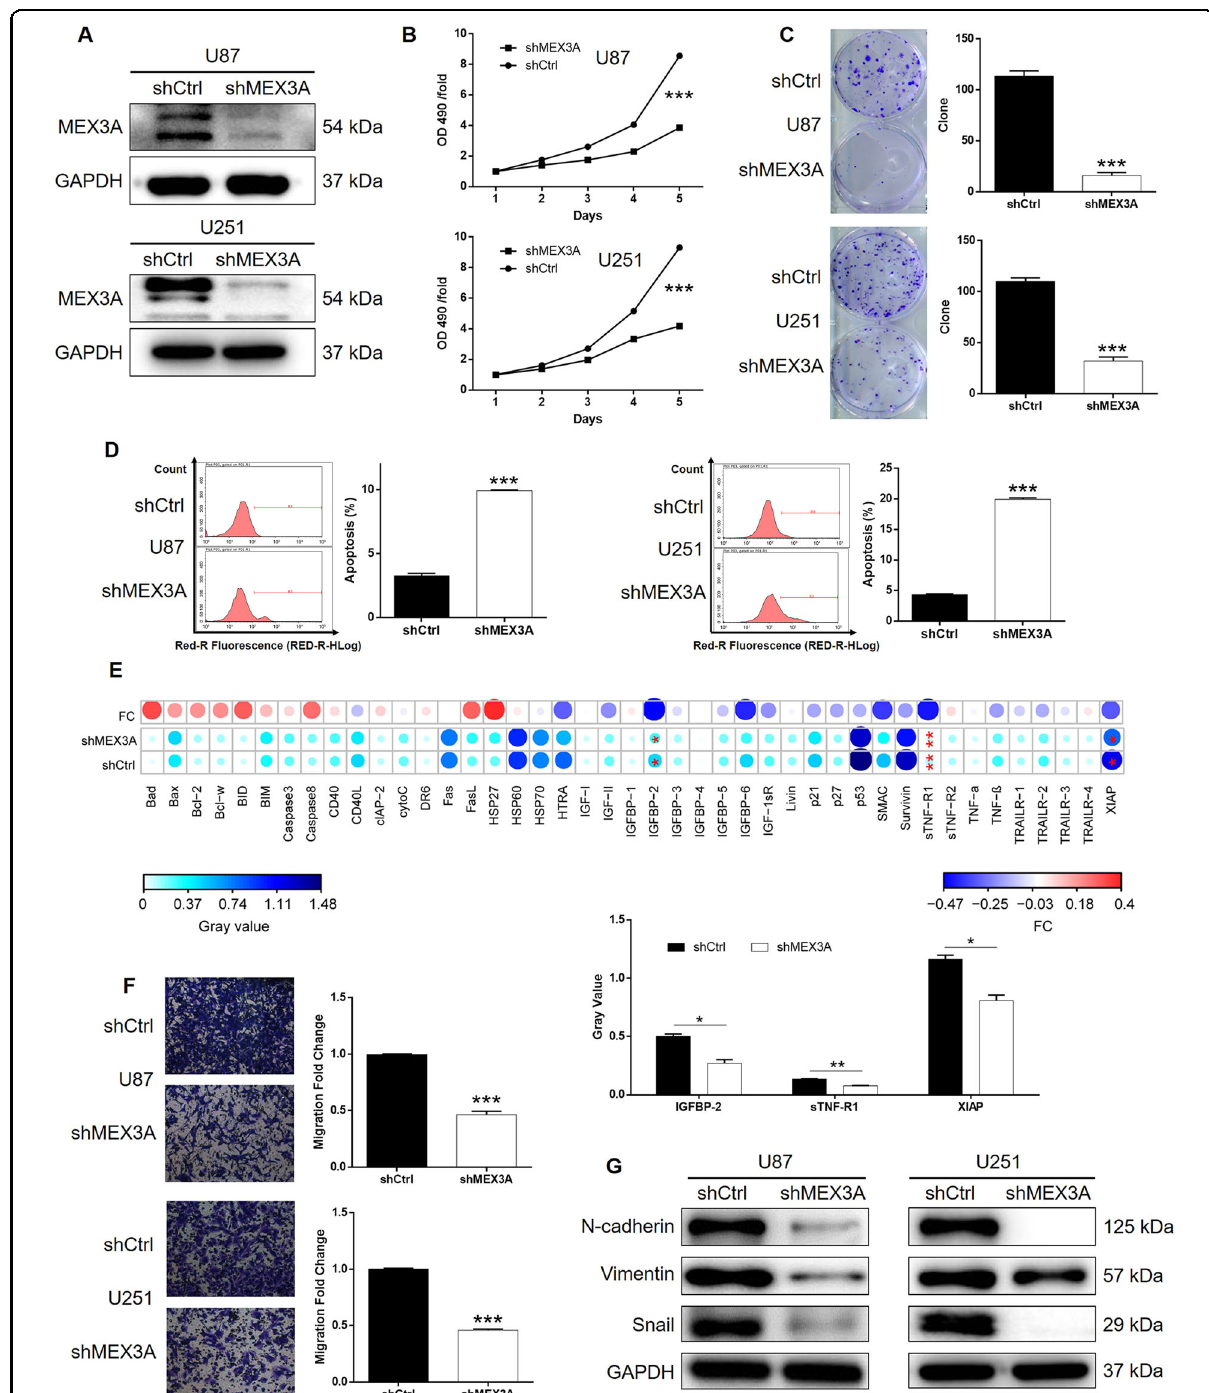
Fig. 2 MEX3A knockdown inhibited glioma development in vitro. A , B Cell models with or without MEX3A knockdown were constructed by transfecting shMEX3A or shCtrl. The knockdown ef fi ciency of MEX3A in BGC-823 and U251 cells was assessed by western blotting ( A ). B MTT assay was employed to show the effects of MEX3A on cell proliferation of U87 and U251 cells. C The number of colonies formed by U87 and U251 was counted to show the effects of MEX3A on their colony formation ability. D Flow cytometry was performed to detect cell apoptosis of U87 and U251 cells with or without MEX3A knockdown. E Human apoptosis antibody array was utilized to analyze the regulatory ability of MEX3A on the expression of apoptosis-related proteins in U251 cells. F The effects of MEX3A on the cell migration ability of U87 and U251 cells were evaluated by Transwell assay. G The expression of EMT-related proteins, including N-cadherin, Vimentin, and Snail, was detected by western blotting in U87 and U251 cells of shMEX3A and shCtrl groups. The representative images were selected from at least three independent experiments. Data were shown as mean ± SD. * P < 0.05, ** P < 0.01, *** P <